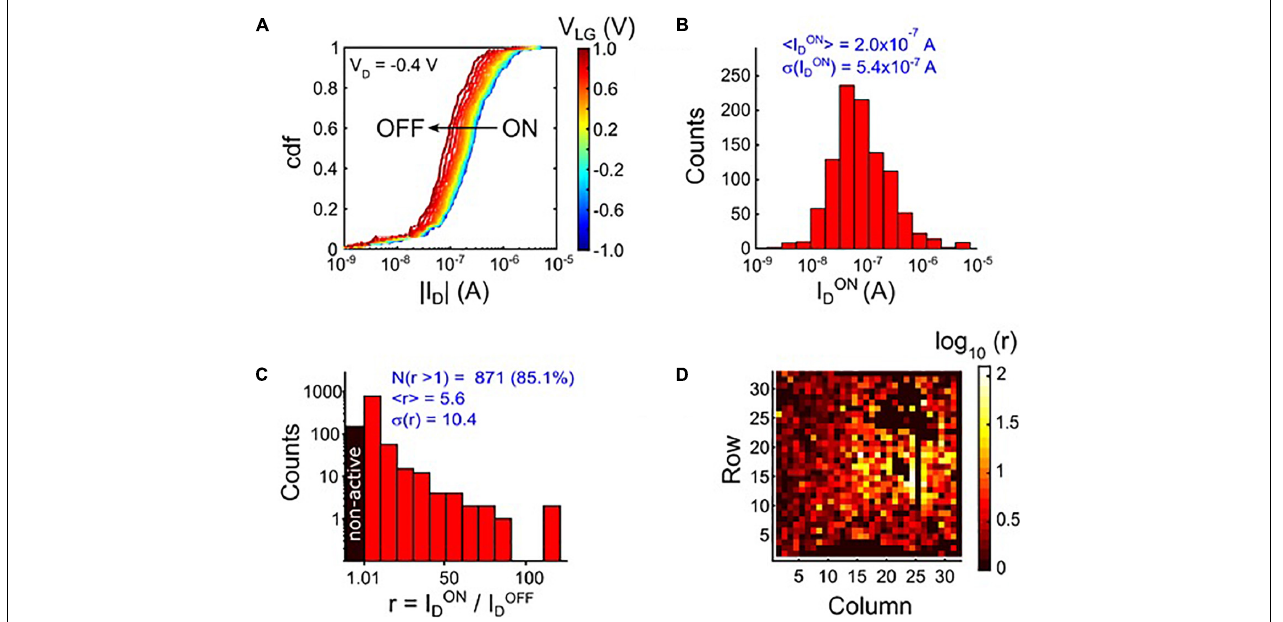
FIGURE 2 | (A) Cumulative distribution function (cdf) of the drain currents for the entire ensemble of 1024 devices, measured row by row (32 pixels at a time). Measurements are shown for several values of the liquid-gate voltage, V LG , extracted from transfer curves. (B) Histogram of I D in the “ON” state at V D = − 0.4 V and V LG = − 0.8 V. (C) Histogram of the ratio r between ON (V LG = − 0.8 V) and OFF (V LG = 1 V) current, r = ID ON /ID OFF , at V D = − 0.2 V. The I D values are extracted from V D sweeps with a constant V LG . The device yield is calculated as the number of transistors with r = ID ON /ID min > 1. For this chip ∼ 85% of all devices were found to be active. (D) Chip map according to the histogram shown in (C) .